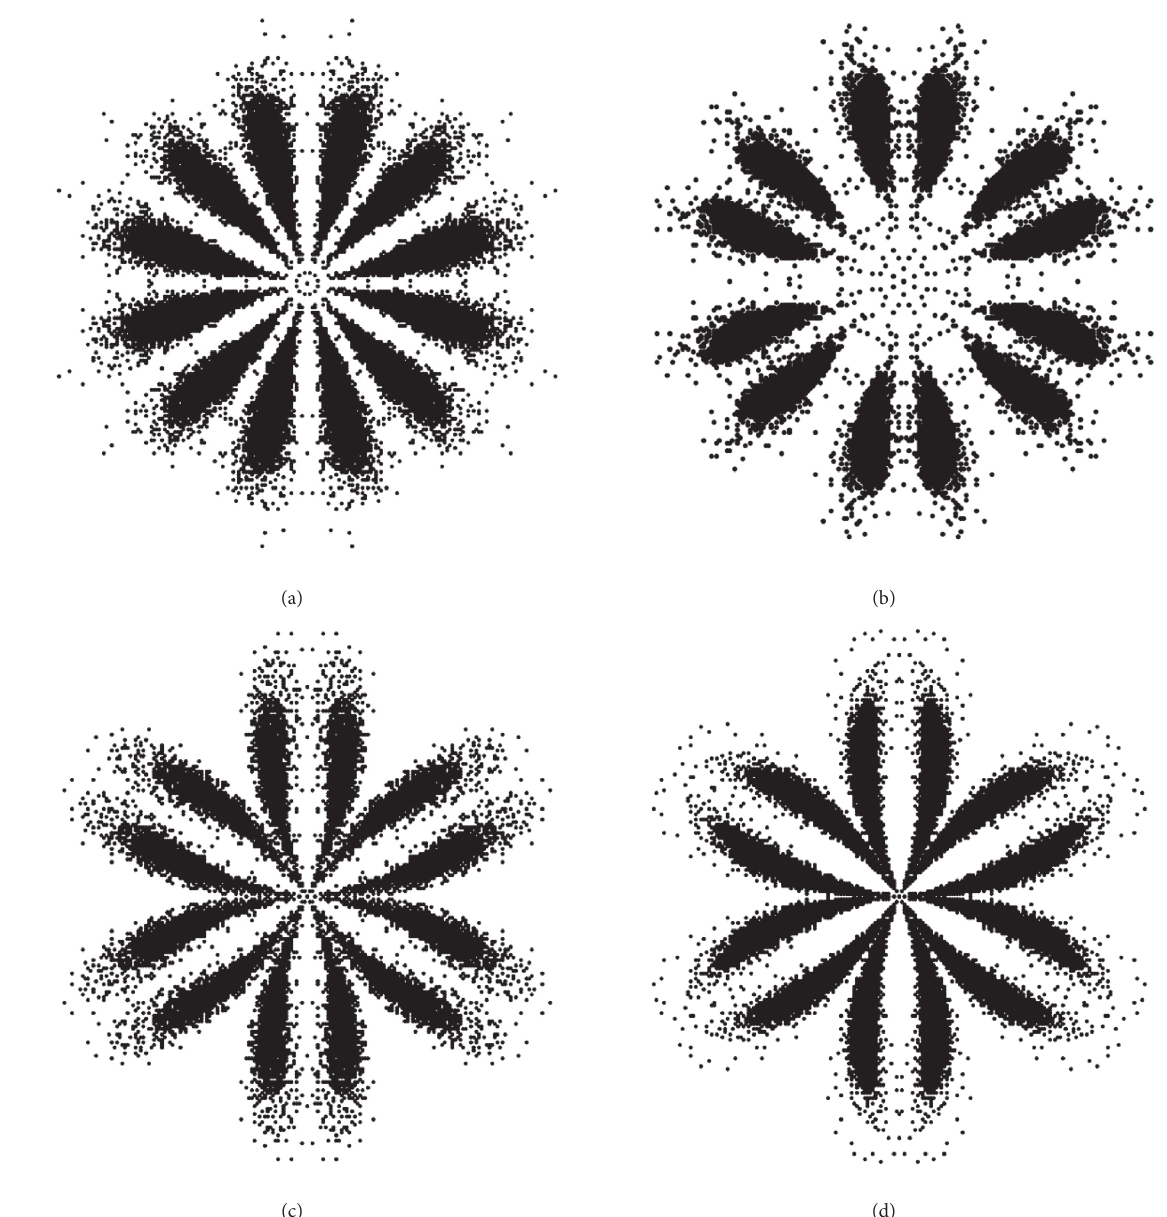
Figure 18: Snowflake images of various states. (a) Normal. (b) Swash plate wear. (c) Loose slipper. (d) Sliding shoe